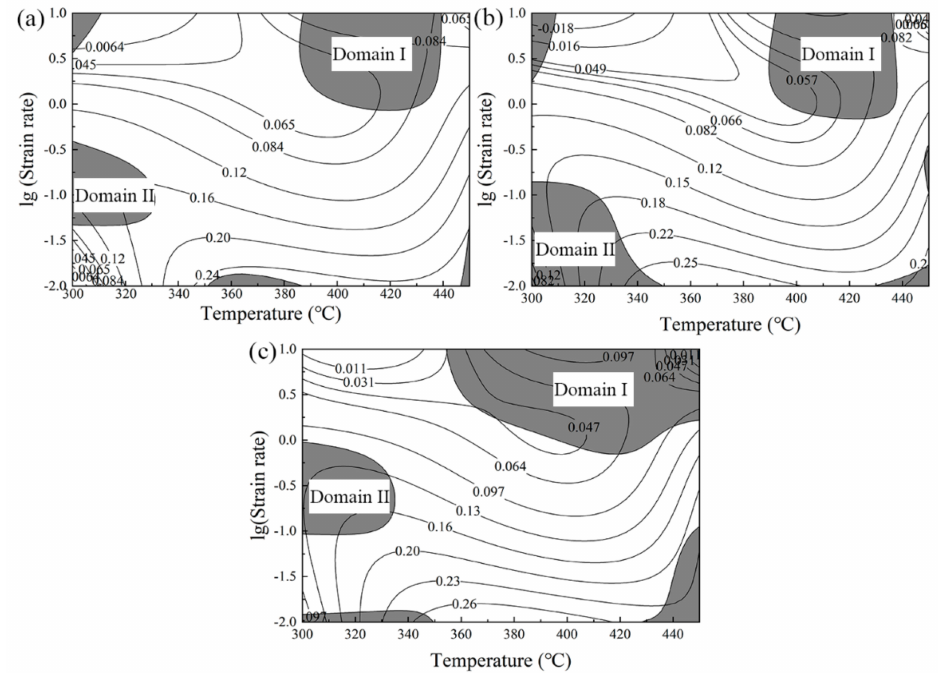
Figure 10. Processing maps of alloy C at various strains: ( a ) strain of 0.2, ( b ) strain of 0.4 and ( c ) strain of